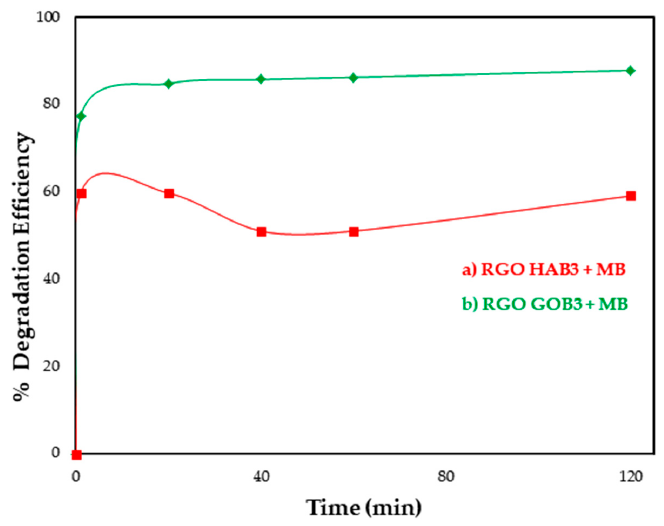
Figure 13. Degradation efficiency (%) of (a) RGO with habanero extract and (b) RGO with gobernadora extract.